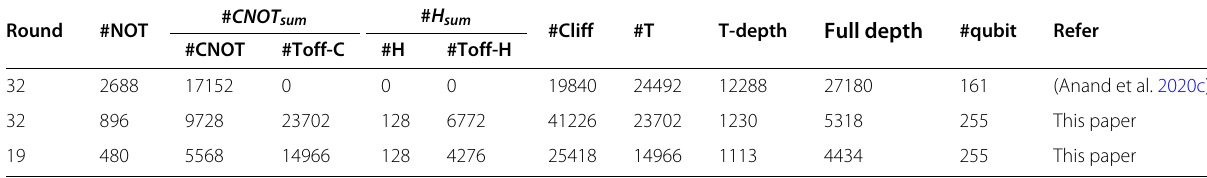
Table 5 The cost of QAA iterator G = U s U g in Fig. 7